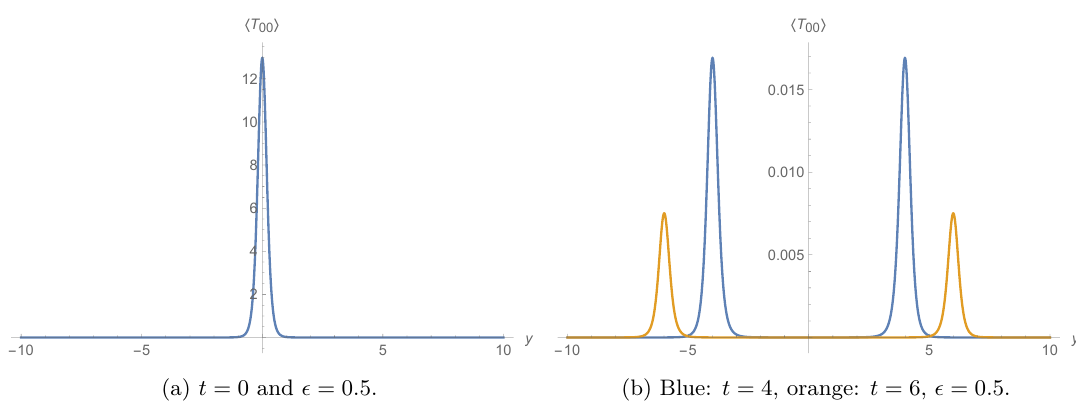
Figure 1 . Energy density profile in the y direction for the excitation created by a quench due to the scalar φ placed at the origin at times t = 0 , 4 , 6 . The width (cid:15) = 0 . 5 . The energy density is spherically symmetric and travels at the speed of light. Unlike in d = 2 , the amplitude decreases in time as the density spreads over a sphere of increasing